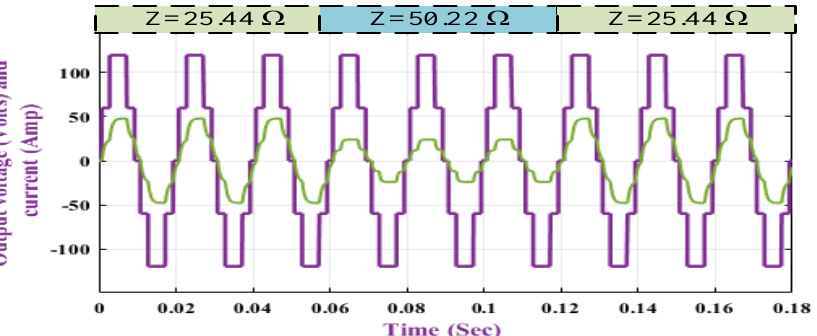
Figure 16. Dynamical R load in nine-level changing from 25 Ω–50Ω– 25 Ω. The current waveform is multiplied by 10.